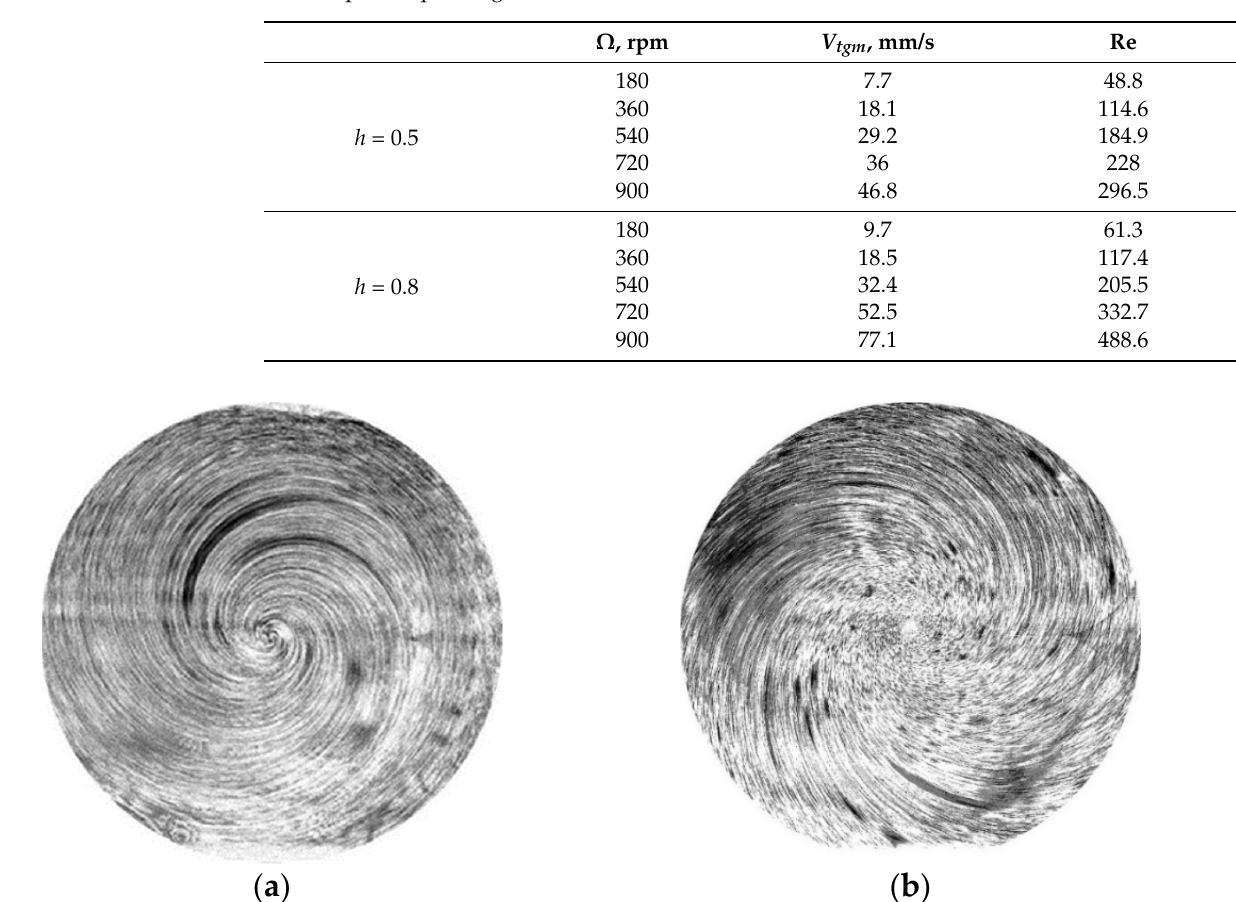
Table 1. The maximum values of the tangential velocity under the interface and the Reynolds number in the liquid, depending on the rotation of the activator.